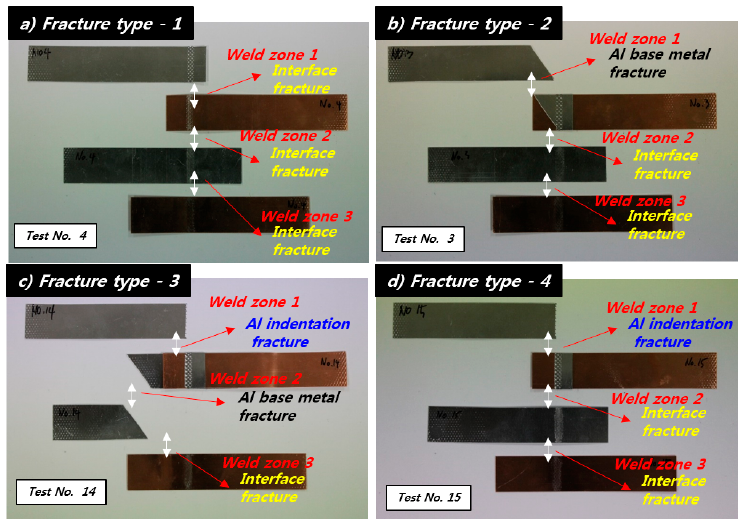
Figure 9. Four kinds of fracture types in a multi-step shear strength test. ( a ) Interface fracture at all weld zones, ( b ) Combination fracture of Al indentation and interface, ( c ) Combination fracture of Al indentation, Al base metal and interface, ( d ) Combination fracture of Al indentation and Al base metal.